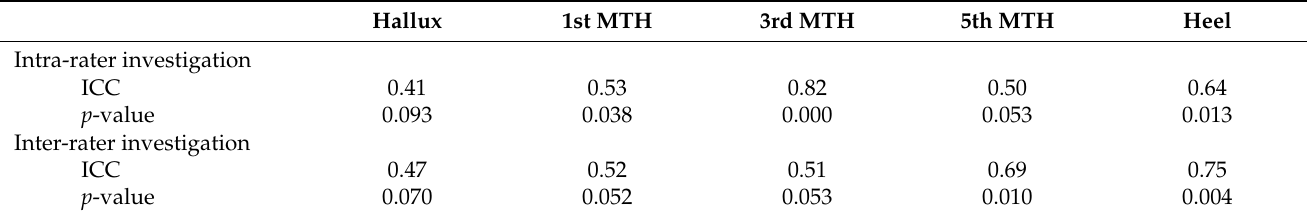
Table 4. Intraclass coefficients (ICCs) of intra- and inter-rater investigation and p